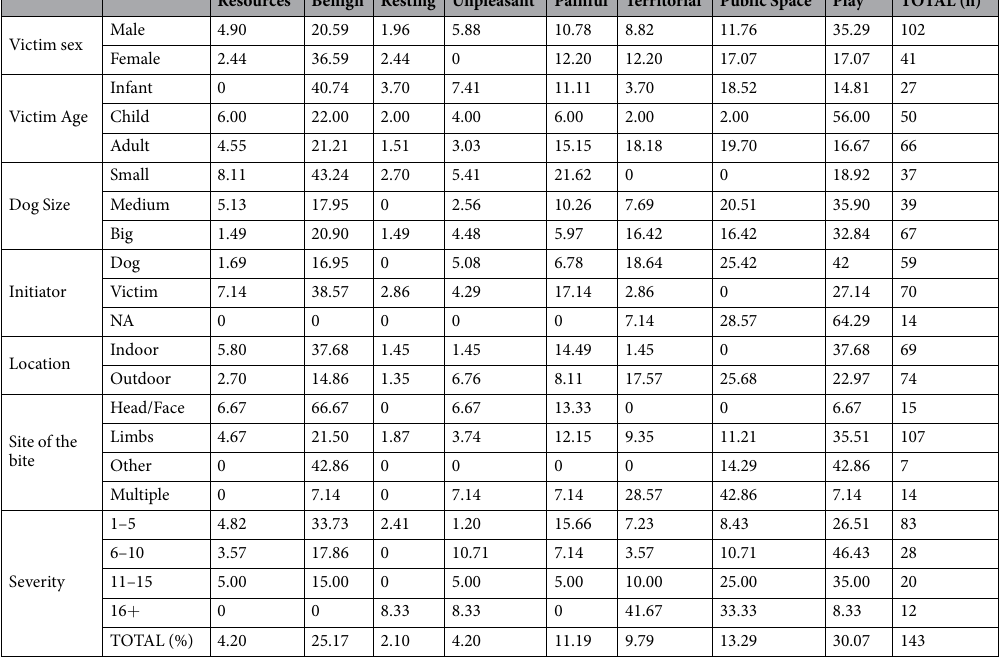
Table 3. Summary of victim, dog, bite and context variables